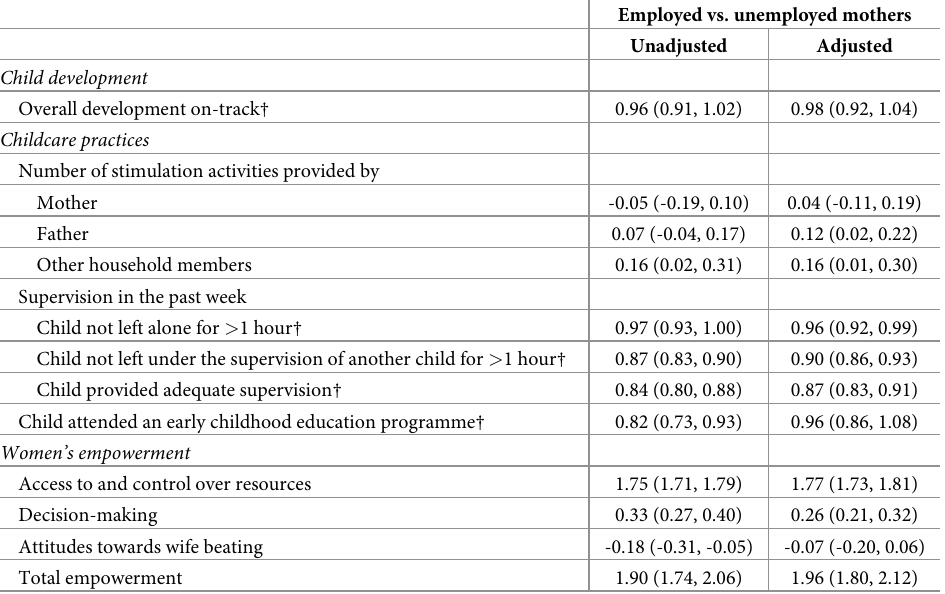
Employed vs. unemployed